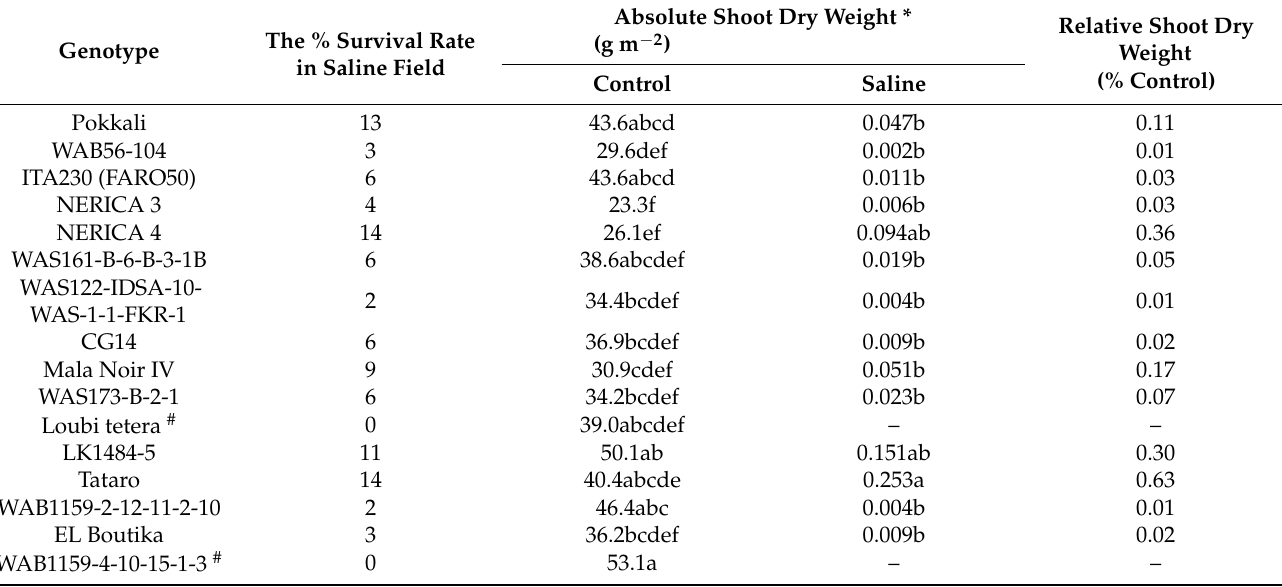
Table 5. Effects of salinity on survival rate and shoot dry weight of rice genotypes grown in a saline wetland (Exp.